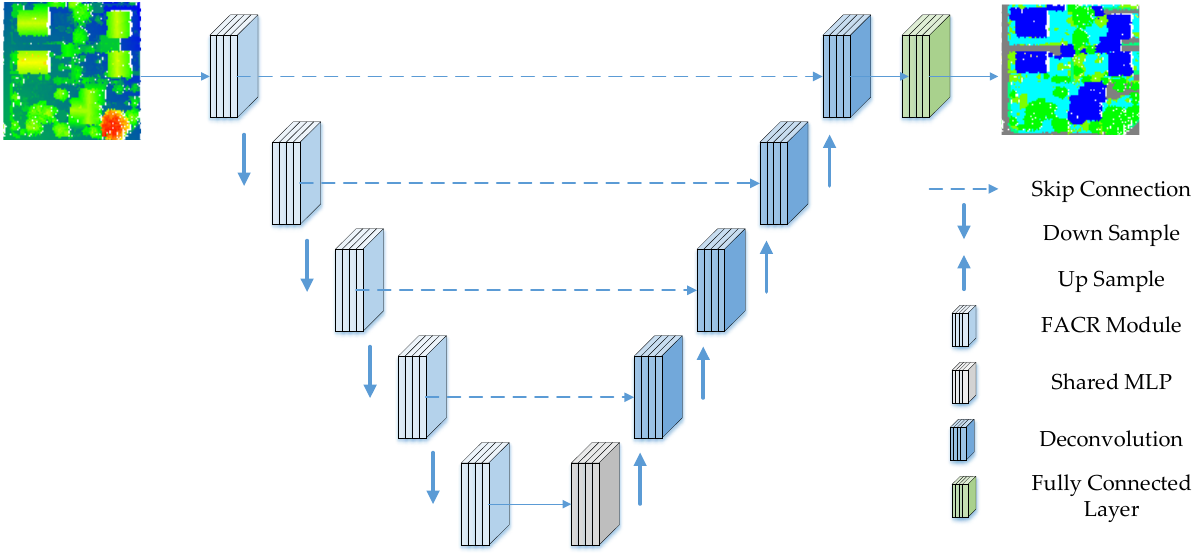
Figure 1. The framework of the proposed integrating normal vector features into an atrous convolution residual network. The input point clouds on the left are colored by elevation, and the output is the classification result.